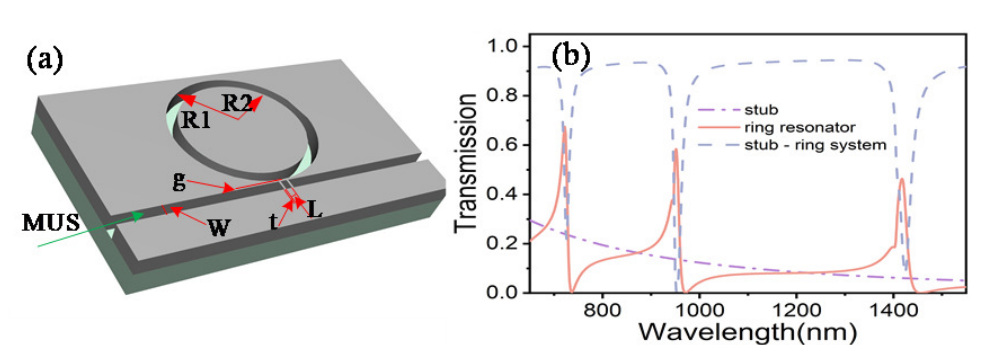
Figure 1. ( a ) 3D schematic of the proposed nanosensor. ( b ) Transmittance profile at n = 1. The purple dashed-dotted line, blue dashed line, and solid orange line represent the transmittance profile of the Fabry–Perot cavity, the ring resonator, and the